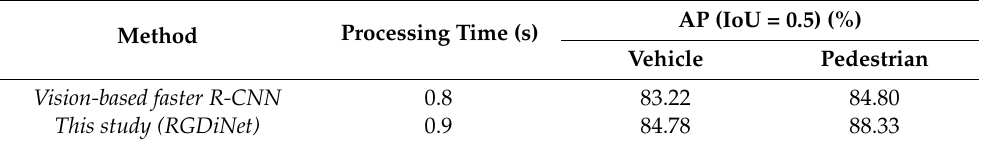
Table 3. AP comparison of vision-based faster R-CNN and RGDiNet when IoU = 0.5 for various objects.